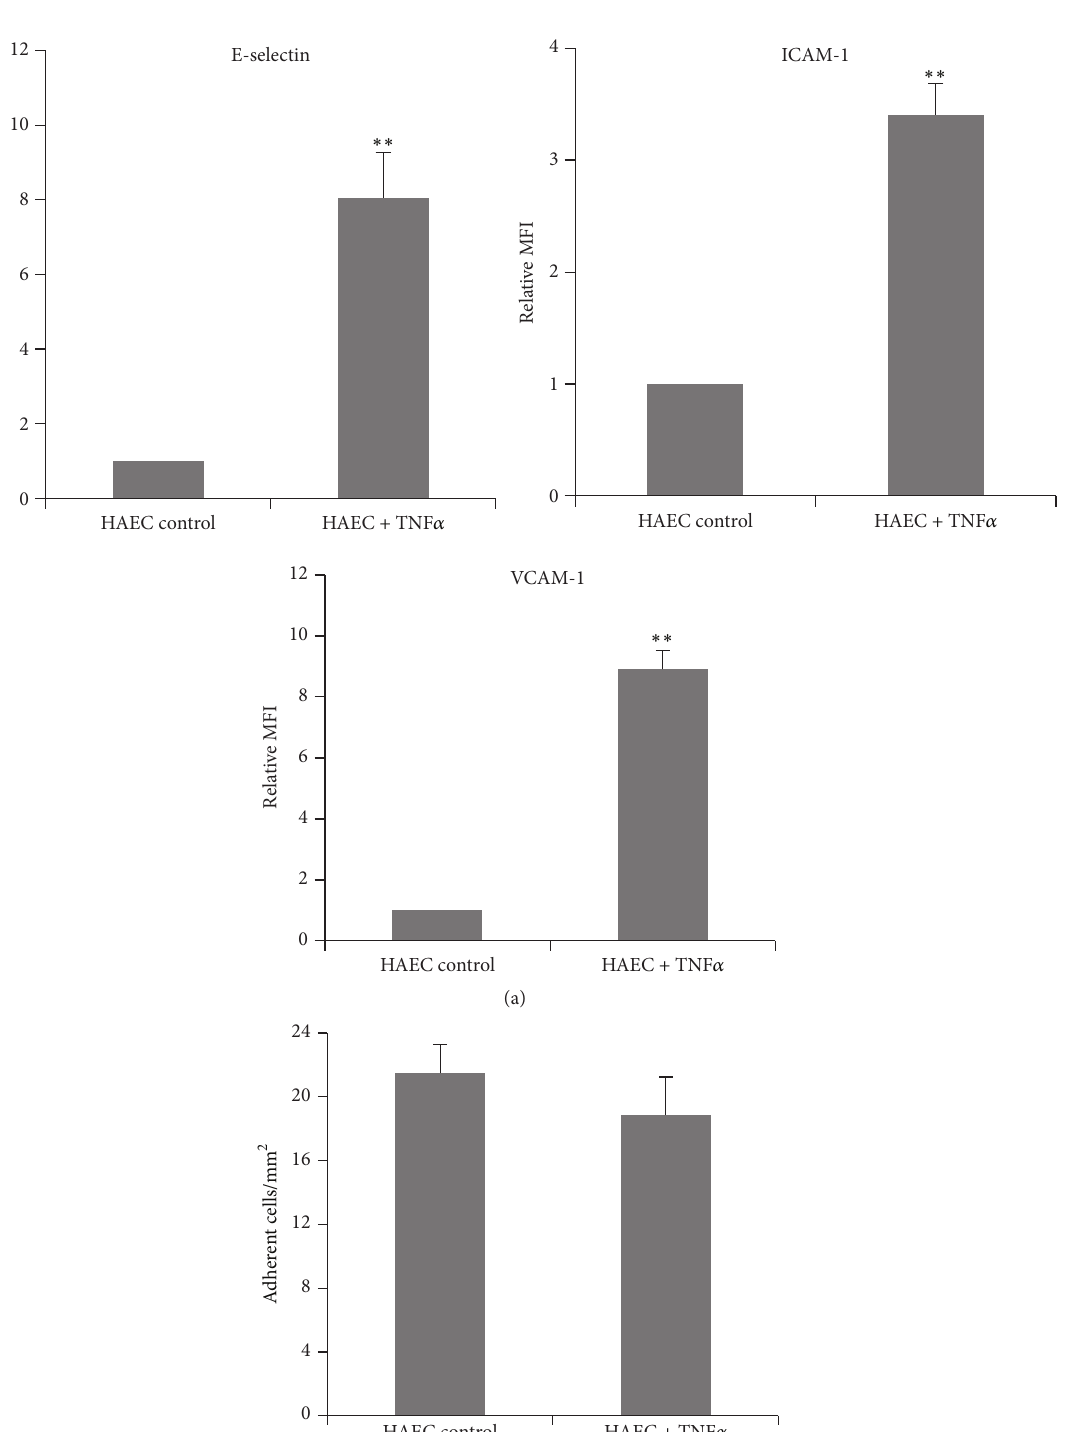
Figure 2: Interaction of LO-EPC with activated HAEC. Surface expression of adhesion molecules in HAEC after stimulation with 0.05 ng/mL TNF 𝛼 (a). Surface expressions of E-selectin, ICAM-1, and VCAM-1 were quantified using flow cytometry. The graph shows relative Mean Fluorescence Intensity (MFI) normalised to untreated cells and represents the mean ± SE of three experiments. ∗∗ 𝑝 < 0.01 . Activation of HAEC did not increase the interaction with LO-EPC (b). 4 × 10 5 LO-EPC were perfused to 3 × 10 4 HAEC for 4min and the data represented as mean ± SE of three